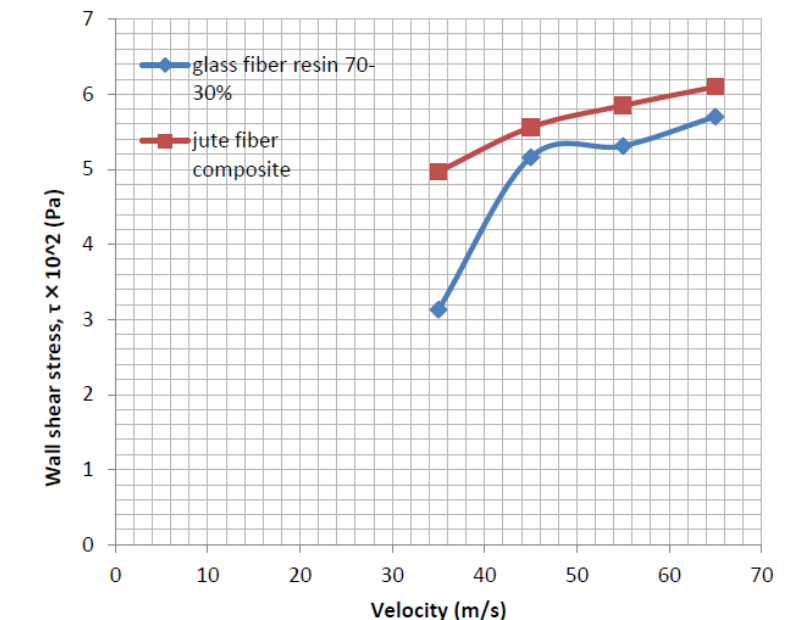
Figure 9: Development of shear stress on two different composite materials for 3 0° angle of